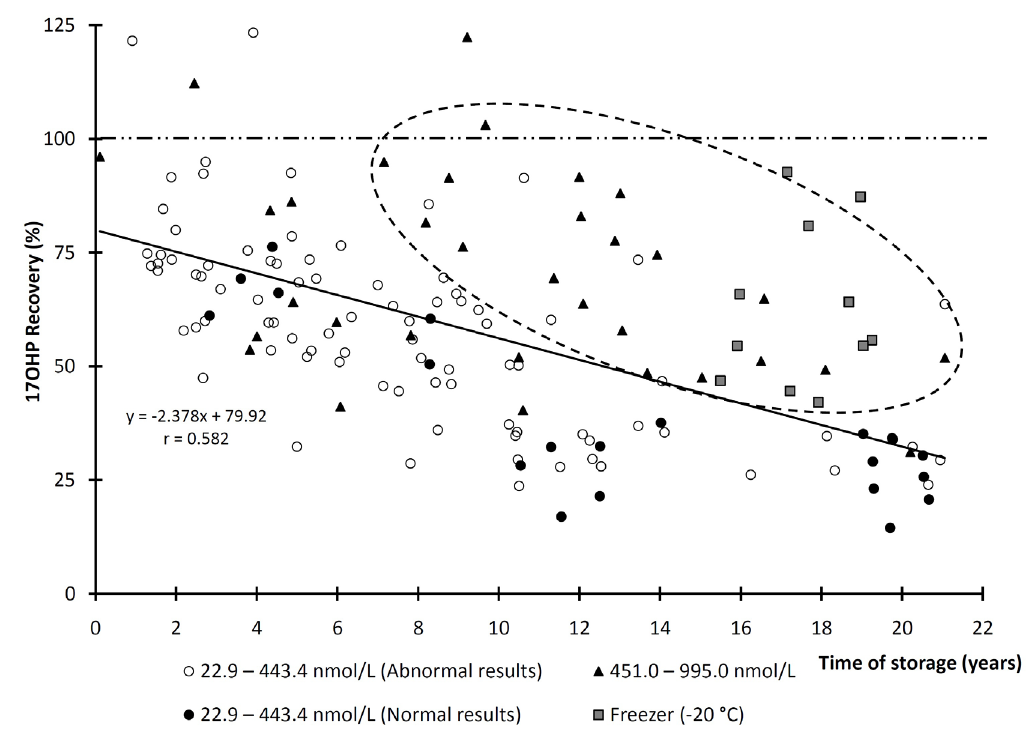
Figure 5. 17OHP recovery at retesting in residual DBS specimens stored in two different storage conditions. Note: References ○, ● and ▲ correspond to residual DBS specimens stored at room temperature. The legend Abnormal/Normal results indicate the qualitative results interpretation at